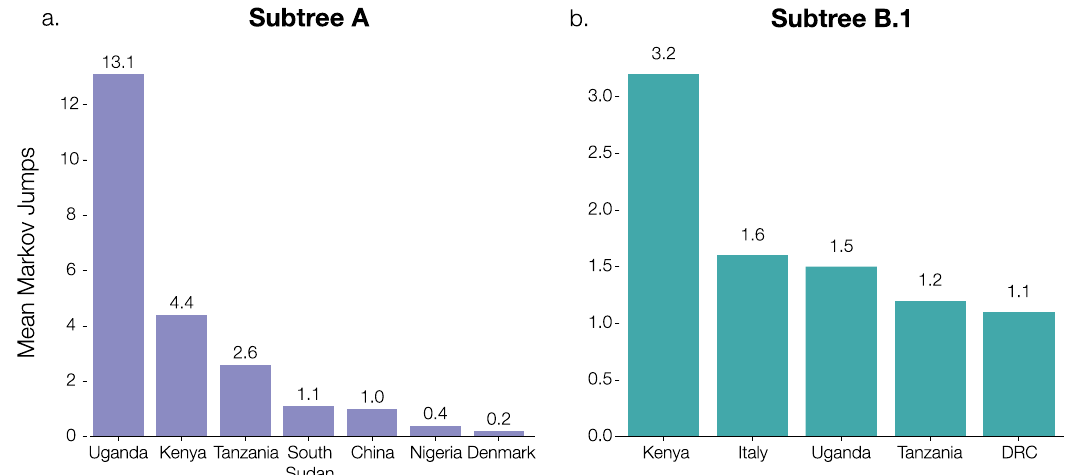
Fig. 7 Supported transitions into Rwanda. Mean number of Markov jumps for supported transition rates into Rwanda (Bayes Factor > 3) for subtrees A and B.1. Support for these rates was determined using BSSVS with a travel history-aware asymmetric discrete phylogeographic model on both subtrees A and B.1. In both analyses, the majority of introductions into Rwanda were inferred to originate from nearby countries in East Africa, suggesting a substantial exchange of viral lineages between neighboring countries in the region. We refer to Supplementary Table S3 for the Bayes factor support values for these reported